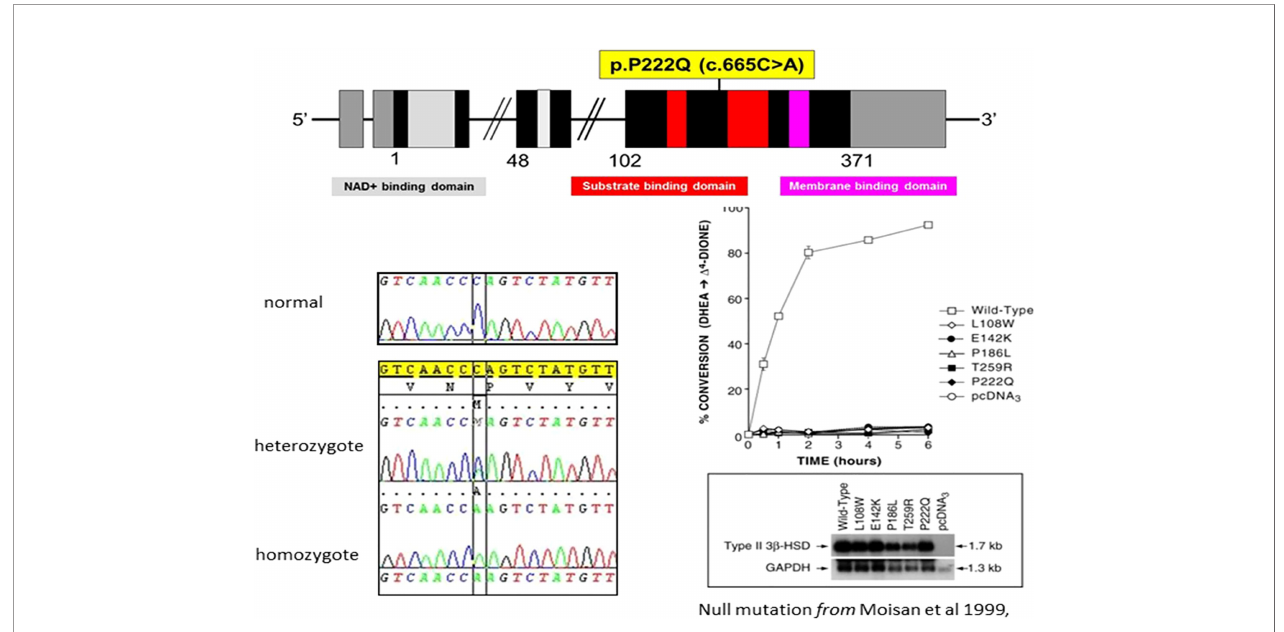
FIGURE 3 | Characteristics of the p.P222Q mutation of the HSD3B2 gene [From Moisan et al, 1999 (27)] — reproduced by kind permission of Oxford University